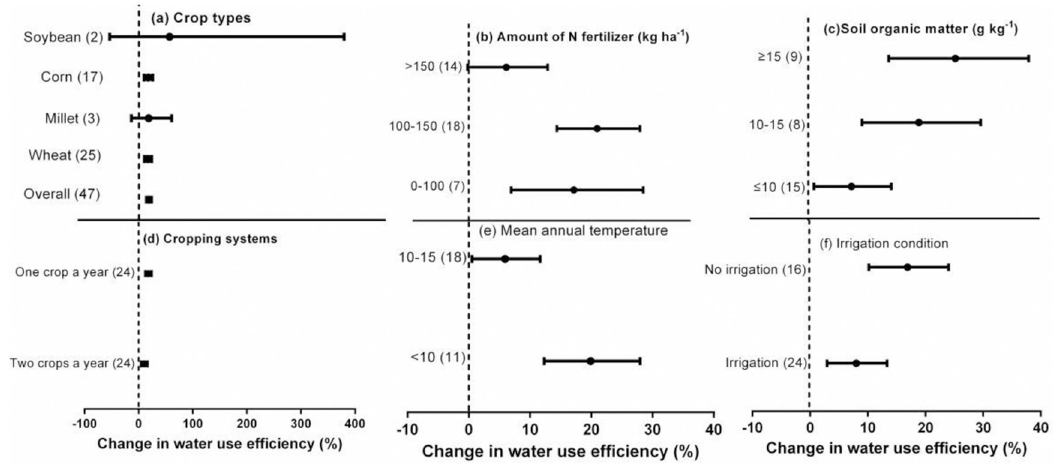
Fig 7. Effect of crop residue return on WUE under different crop types (a), amount of N fertilizer (b), soil organic matter (c), cropping systems (d), mean annual temperature (e), and irrigation condition (f). Error bars represent the mean value ± 95%